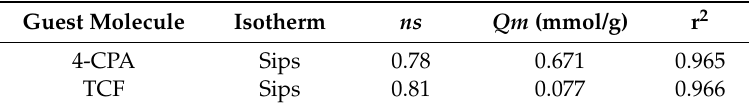
Table 7. Qm values for both